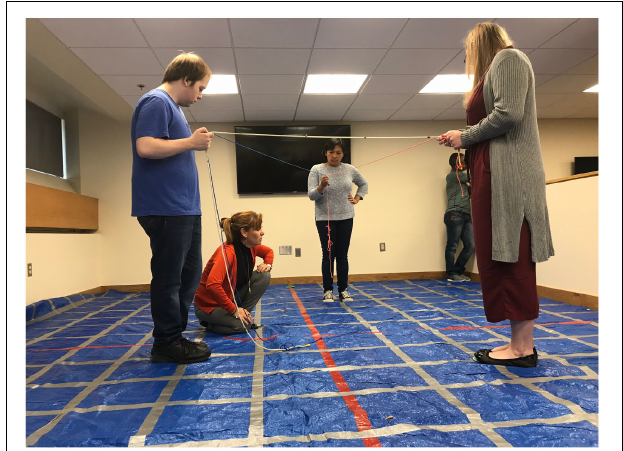
FIGURE 10 | Enacting Euclidean transformations: Guided by a university instructor, three mathematics teachers study a tarped Cartesian coordinate system in preparation for rotating a rope triangle over the plane. They current occupy (–1, –1), (1, 4), and (2,